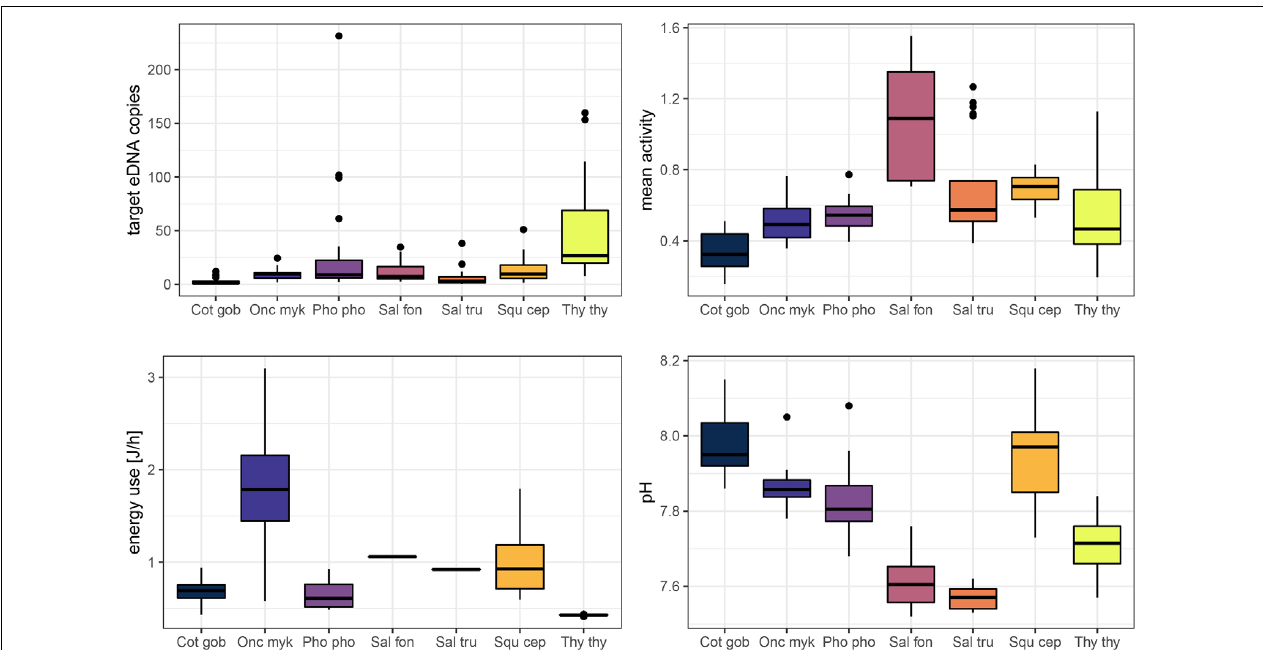
FIGURE 3 | Key parameters obtained during the experiment for single fish. Boxplots display target eDNA copies per µ l extract, energy use [J/h], mean activity, and pH per fish species. Fish species are abbreviated: “Cot gob,” Cottus gobio ; “Onc myk,” Oncorhynchus mykiss ; “Pho pho,” Phoxinus phoxinus ; “Sal fon,” Salvelinus fontinalis ; “Sal tru,” Salmo trutta ; “Squ cep,” Squalius cephalus ; “Thy thy,” Thymallus thymallus . The variables target eDNA copies, mean activity, and energy use were normalized by fish mass to control for the effect of this confounding